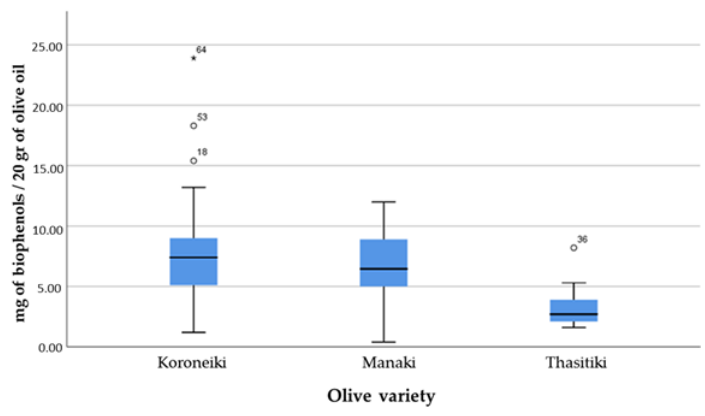
Figure 1. Comparison of biophenol concentrations with the olive variety.